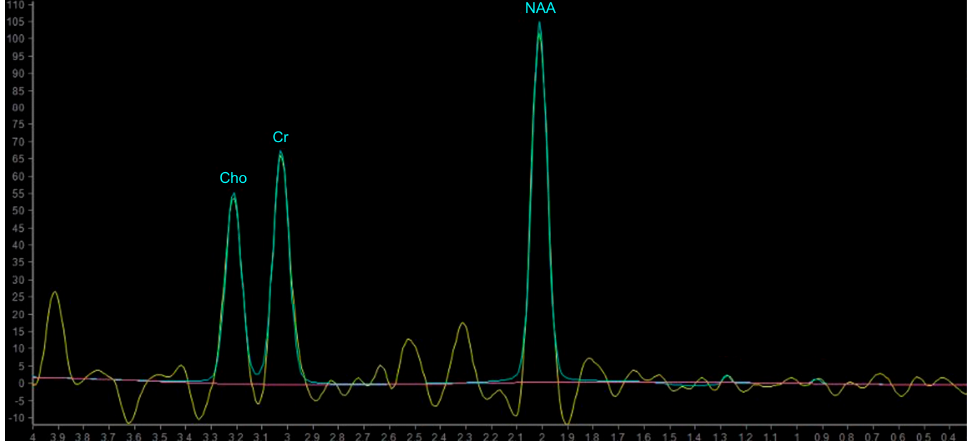
Figure 8. Example of normal spectrum (SV TE 144ms). Normal MR spectrum demonstrating Cho, Cr and NAA peaks.